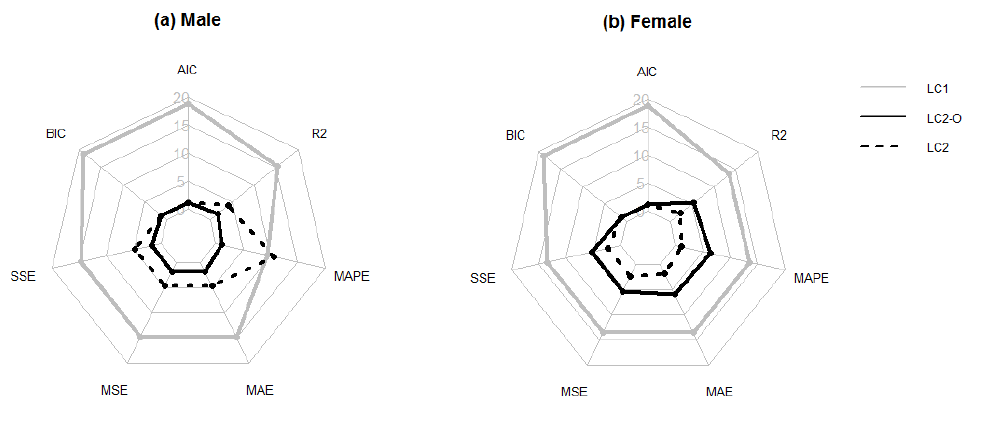
Figure 5. Radar graphs summarizing the number of countries for which each model (LC, LC2, and LC2-O) achieves the best forecasting ability according to the leave-one-out method for males ( a ) and females ( b